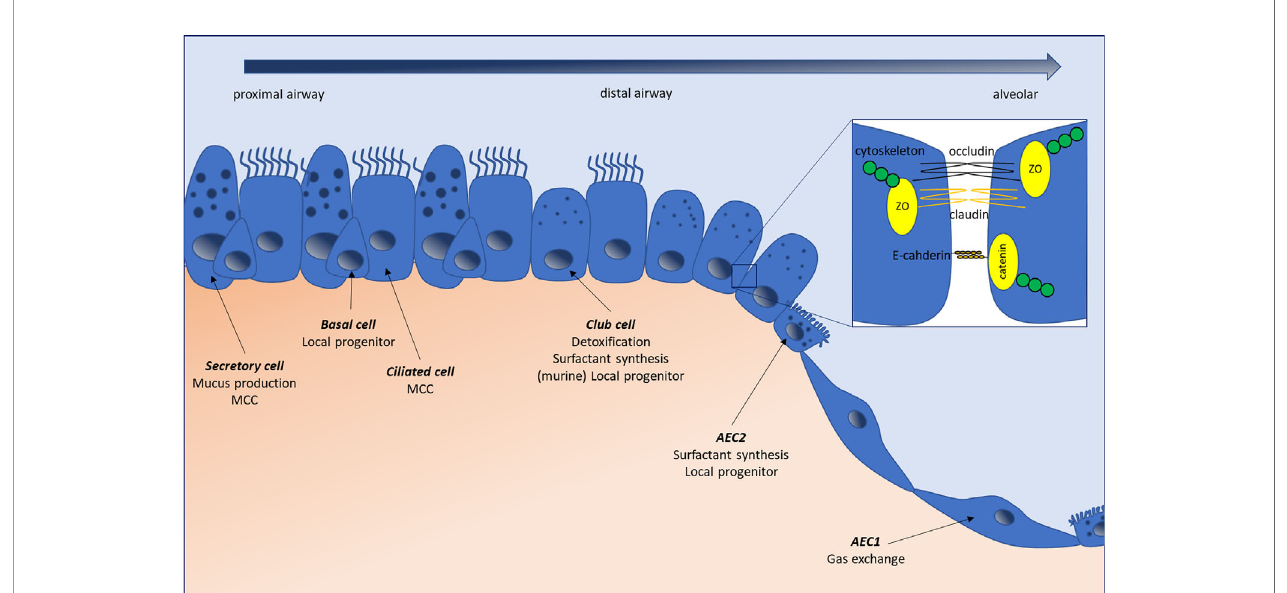
FIGURE 1 | The normal lung epithelium composition changes along the respiratory tree from proximal airways to alveolar areas. Secretory cells produce the mucus lining the airways, which is moved upstream by the ciliated beats originating from ciliated cells. Basal cells have a local progenitor function, possessing the ability to differentiate into several cell types, including secretory and ciliated cells. In small airways, basal and secretory cells are progressively replaced by club (ex-Clara) cells, which can serve as local facultative progenitors (besides basal cells), secrete components of the bronchiolar lining fl uid, and play a detoxifying role through their expression of cytochrome p450. In the alveoli, alveolar type-1 epithelial cells (AEC1) are responsible for gas exchange, while alveolar type-2 epithelial cells (AEC2) produce surfactant and serve as local progenitors. Epithelial cells are connected by tight- and adherens junctions, forming a continuous layer separating the intra- luminal content from the submucosal environment and regulating intercellular permeability. Tight junctions are composed of integral membrane proteins like claudins and occludins, which are linked to the cytoskeleton through cytosolic protein complexes such as Zonula Occludens (ZO). Adherens junctions, formed by E-cadherin proteins, linked to the cytoskeletion by catenins are responsible for the maintenance of cell-cell adhesion while being involved in many intracellular signaling and transcriptional pathways. MCC, mucociliary